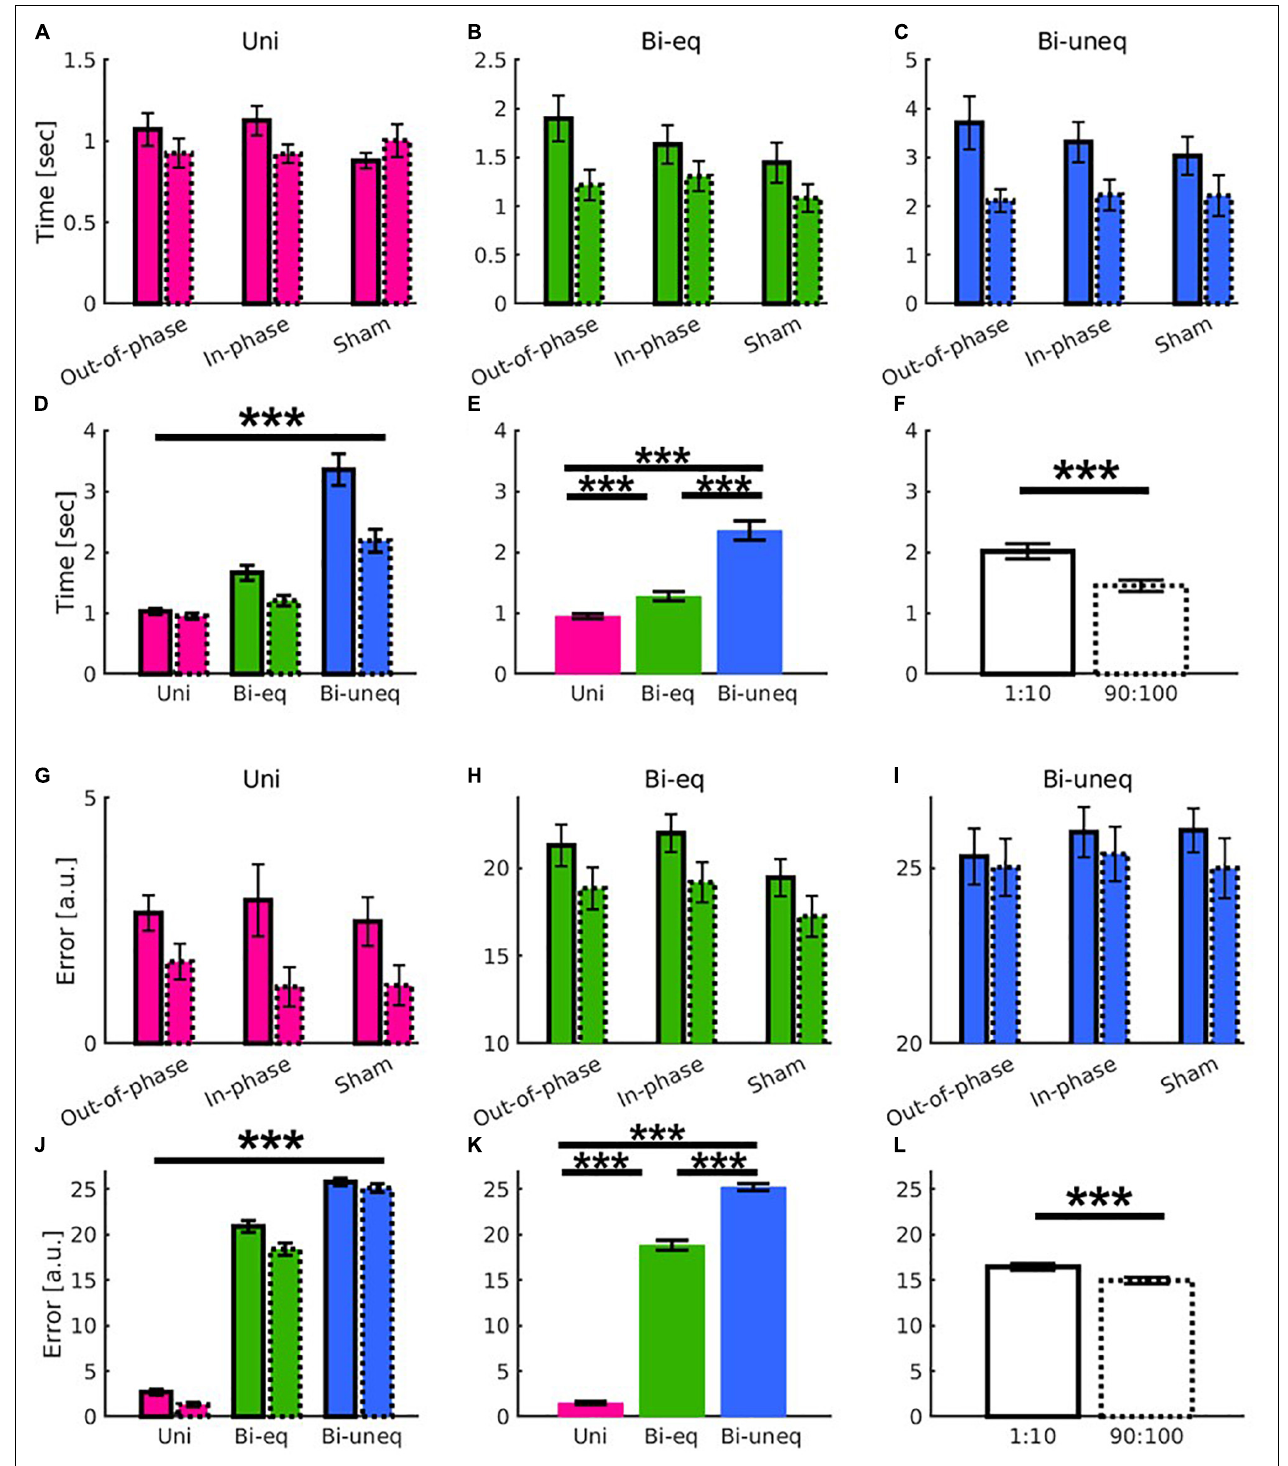
FIGURE 5 | Results showed learning yields main effects of time and condition as well as distinct learning-related patterns for the different conditions ( Uni : pink; Bi eq : green; Bi uneq : blue), but beta tACS did not modulate the patterns in either movement time (A–F) or error (G–L) as shown in the comparison of the first ten (solid frame) and last ten trials before the end of stimulation (dashed frame). (A–C,G–I) Interaction between time × condition × group individually scaled for greater visibility. (D,J) Significant interaction between time × condition. (E,K) Main effect of condition. (F,L) Main effect of time. Error bars are standard errors of the mean. Significance stars ∗∗∗ mean p < 0.001.